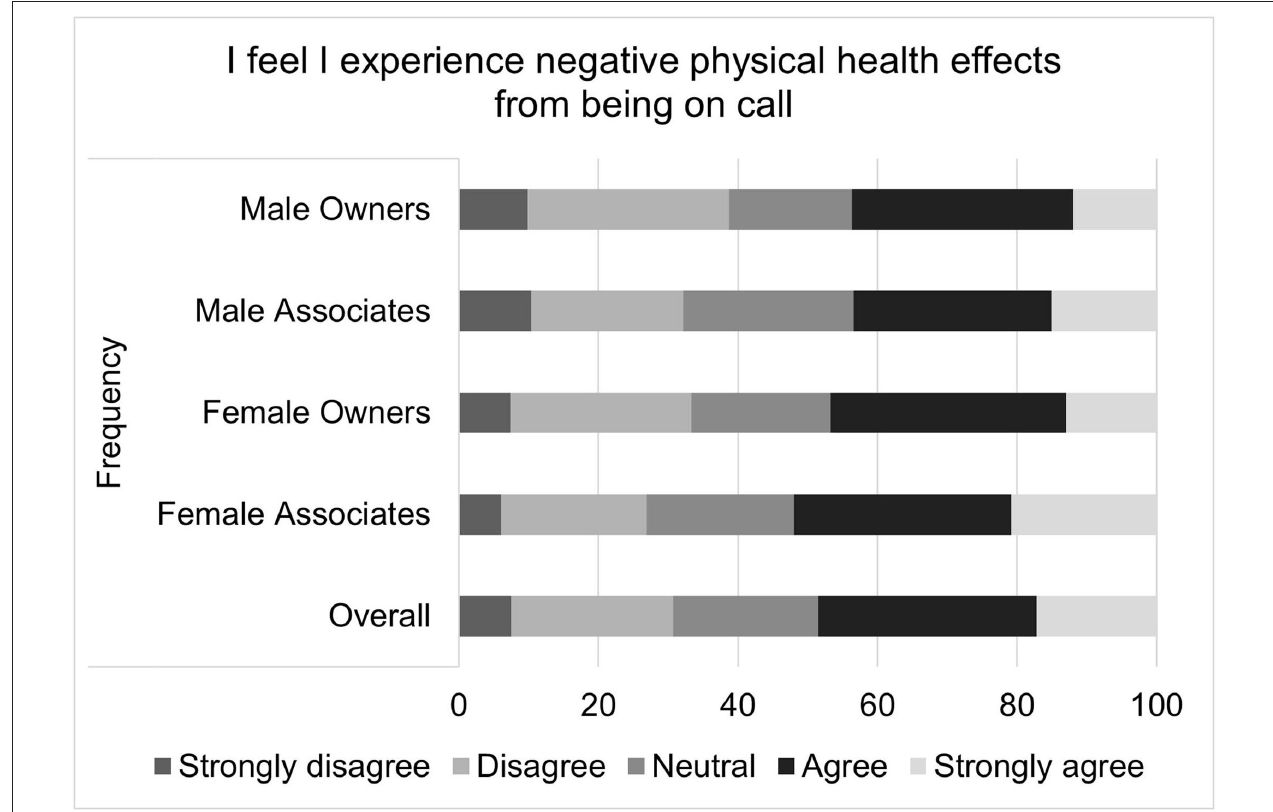
FIGURE 11 | Extent to which being on-call causes significant disruptions in family/personal life, as reported by male and female practice owners and associate veterinarians.